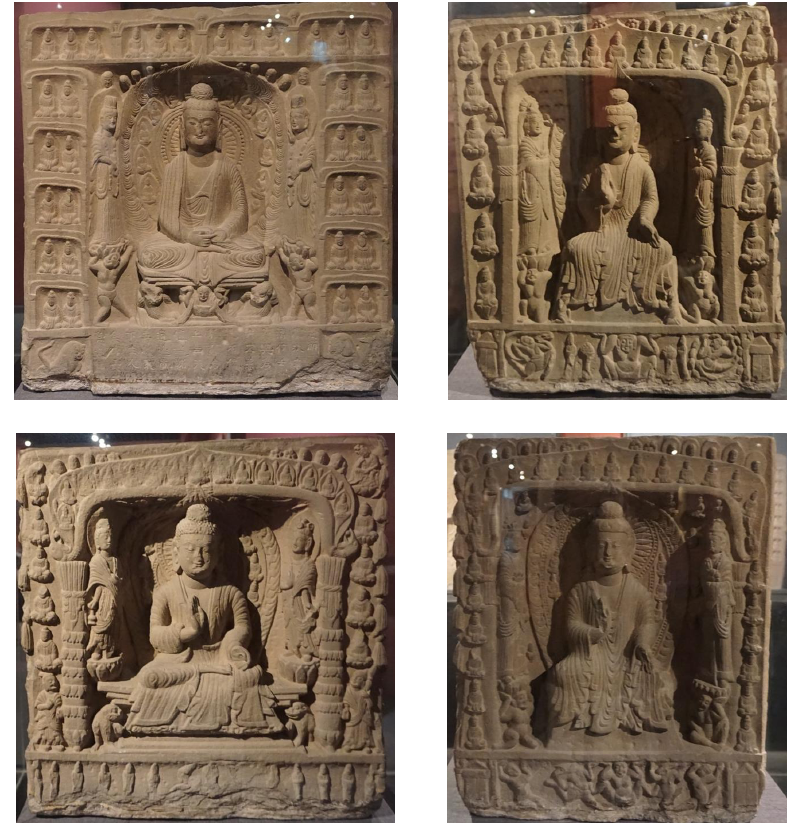
Figure 8. Stone block dated to 501, Northern Wei. Beilin Museum, Xi’an, Shaanxi province. Photographs taken by the author.